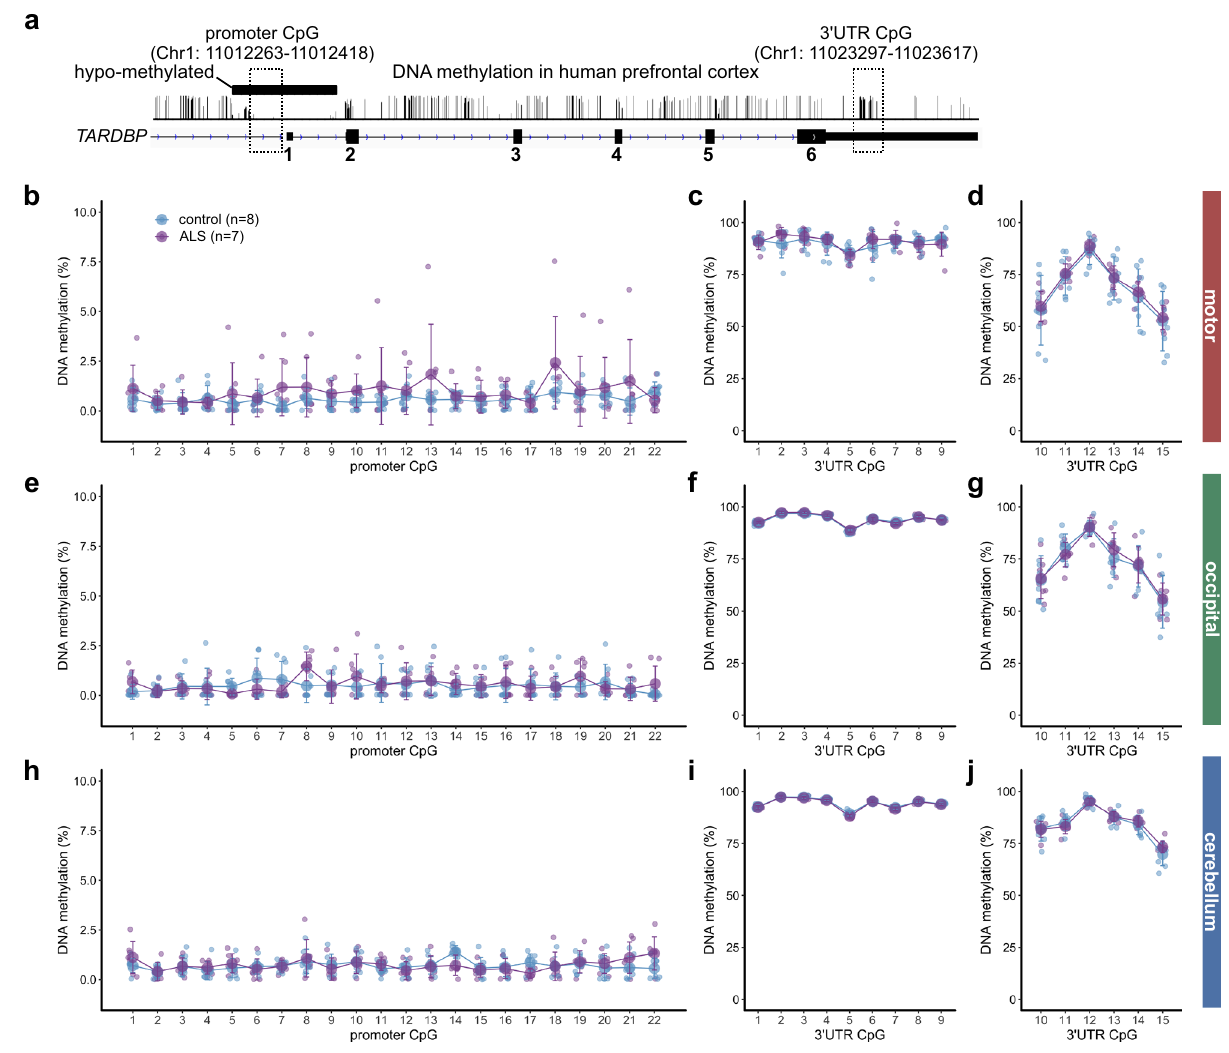
Fig. 4 Percentages of TARDBP gene DNA methylation in the human brain. a Schematic of the DNA methylation status of the human prefrontal cortex obtained from the methylomic database and the CpG region analyzed by bisul fi te amplicon sequencing. b – j DNA methylation percentages of each CpG site in the TARDBP promoter region ( b )( e )( h ) and TARDBP 3 ′ UTR ( c )( d )( f )( g )( i )( j ) in 8 controls and 7 ALS patients. Mean (large circles)±